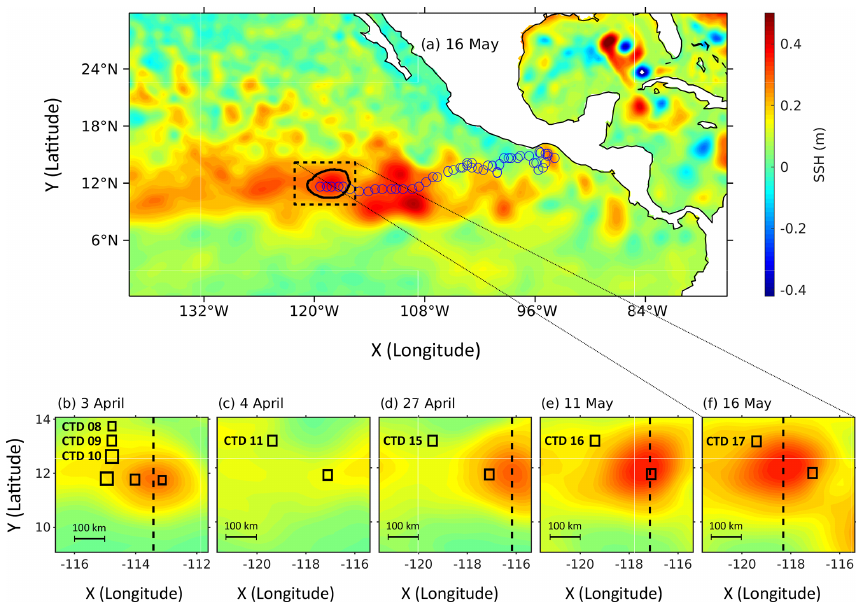
Figure 4. (a) Satellite altimeter sea surface height (SSH) data for 16 May 2019. The under-study eddy is detected using a geometry-based algorithm, and its edges are shown by the solid black lines. The weekly eddy trajectory of the ACE analyzed in this study is shown by the blue circles from 1 August 2018 to 20 May 2019. Five configurations of the eddy are shown for (b) 3 April, (c) 4 April, (d) 27 April, (e) 11 May, and (f) 16 May. The black squares show the location of CTD profiles obtained in our study. The dashed black lines show the locations of zonal transects with maximum sea surface height at which vertical profiles of seawater properties were